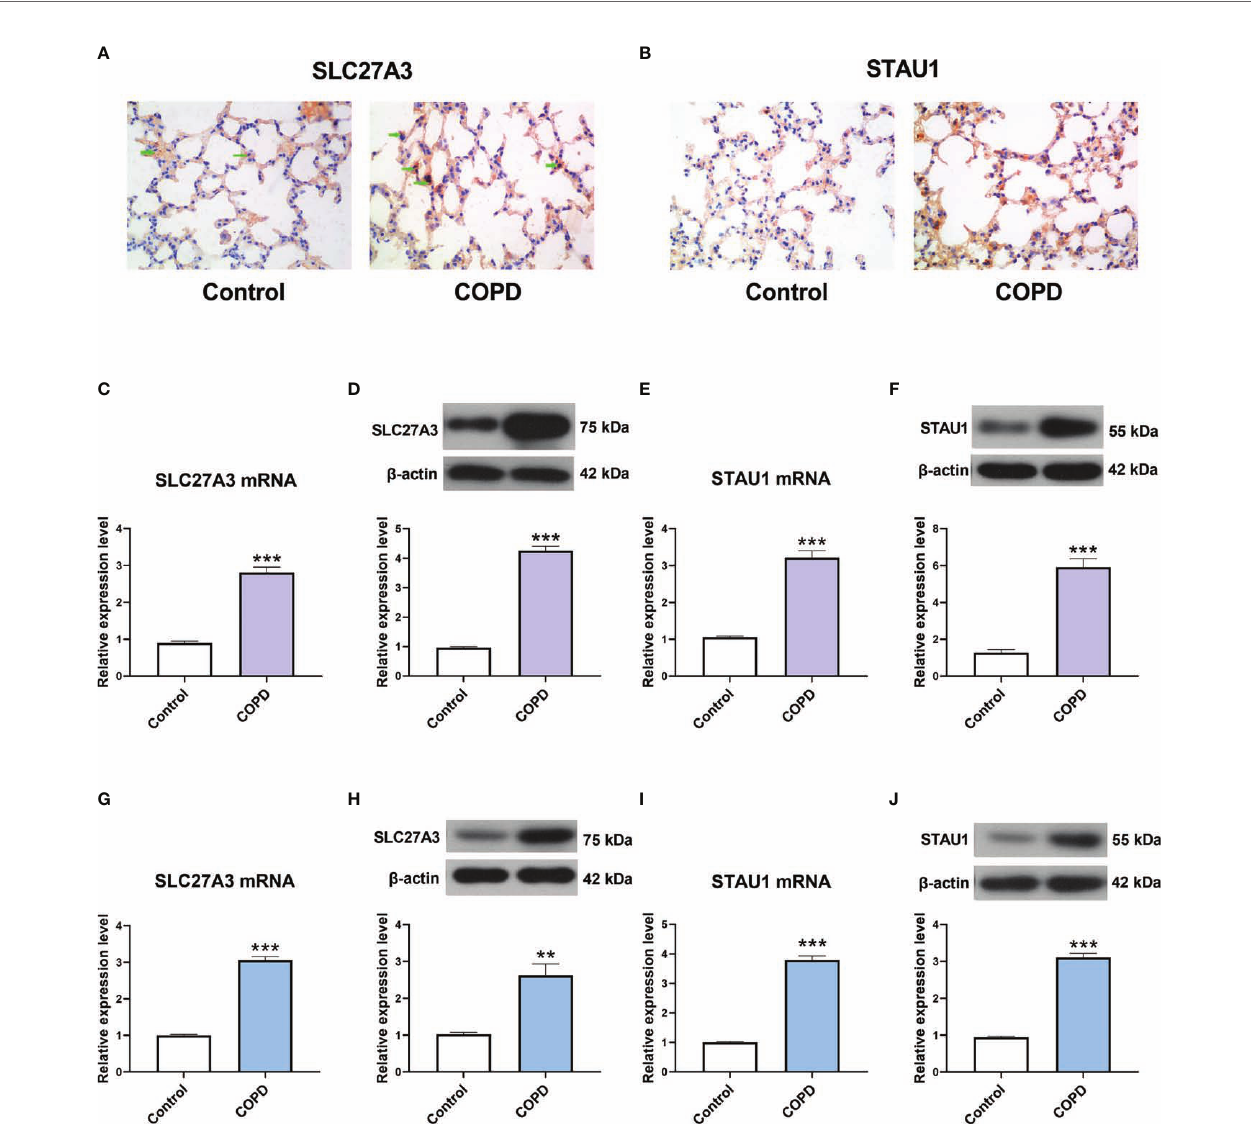
FIGURE 9 | The expression of SLC27A3 and STAU1 in COPD models. (A) Representative immunohistochemistry images of SLC27A3 in lung tissues of mice. (B) Representative immunohistochemistry images of STAU1 in lung tissues of mice. (C) The expression of SLC27A3 mRNA in lung tissues of mice. (D) The expression of SLC27A3 protein in lung tissues of mice. (E) The expression of STAU1 mRNA in lung tissues of mice. (F) The expression of STAU1 protein in lung tissues of mice. (G) The expression of SLC27A3 mRNA in BEAS-2B cells. (H) The expression of SLC27A3 protein in BEAS-2B cells. (I) The expression of STAU1 mRNA in BEAS-2B cells. (J) The expression of STAU1 protein in BEAS-2B cells. **P < 0.01, ***P < 0.001 vs.